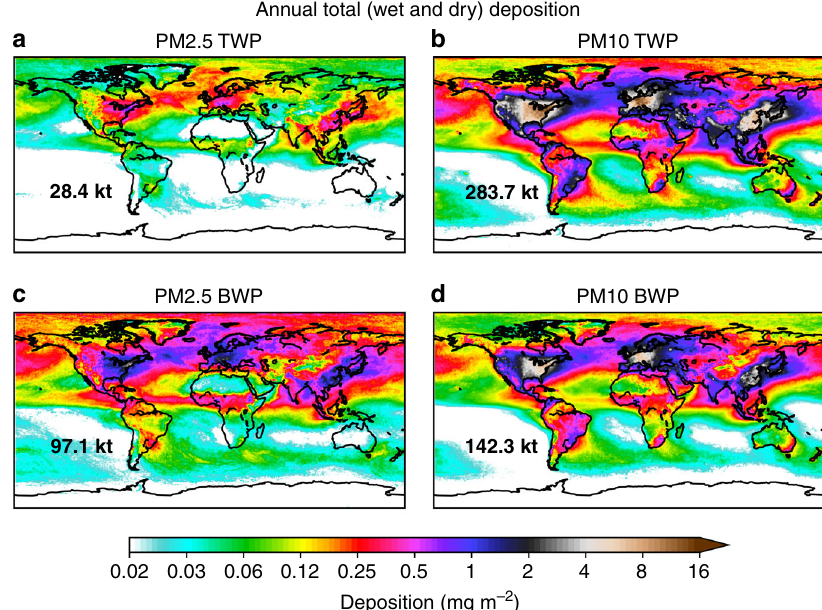
Fig. 2 Wet and dry deposition of road microplastics. Annual total (wet and dry) deposition of tyre wear particles (TWPs) and brake wear particles (BWPs) in PM2.5 and PM10 size classes, respectively. The projected deposition has been calculated as the geometric mean of all simulations using TWP emissions estimated using the CO 2 ratio method and the GAINS model and using BWP emissions calculated from the GAINS model, respectively. The simulations comprise 120 ensemble members with different assumption for the airborne fraction ( fi ve for each of the PM2.5 and PM10 fractions), particle size distribution (eight for each of the PM2.5 and PM10 fractions) and CCN/IN (cloud condensation nuclei/ice nuclei) ef fi ciency (three different sets of scavenging coef fi cients per fraction) following a log-normal distribution (see “ Methods ” ). Bold numbers at the left bottom of each panel represent